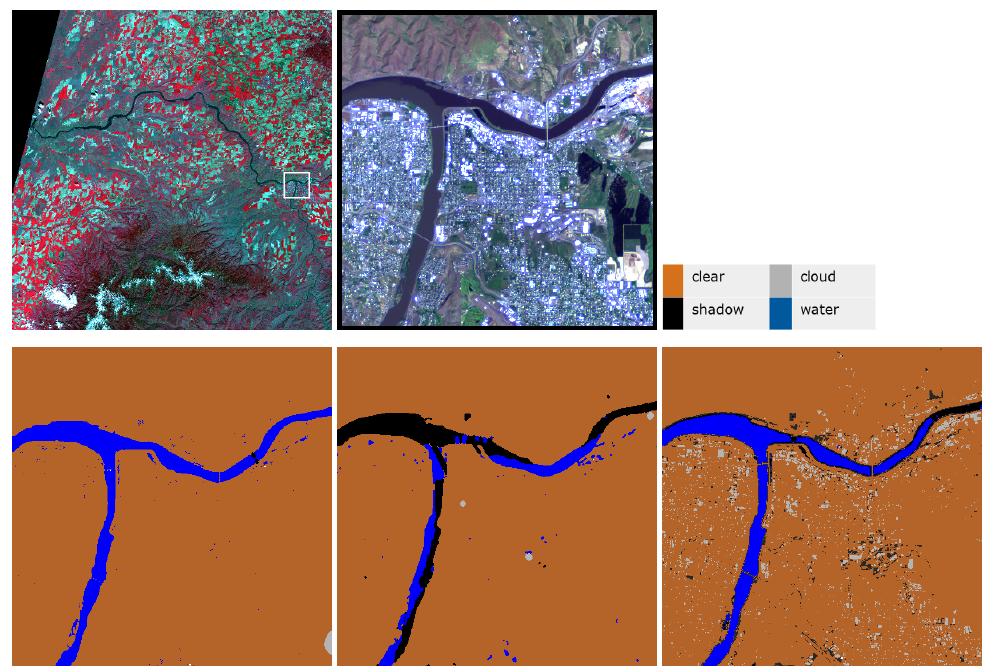
Figure 10. Top row (left to right): CIR (RGB = 865,665,560 nm) composite and true color (RGB = 665,560,443 nm) subset of scene ID 20 (USA Rimrock). Bottom row (left to right): Fmask, ATCOR, and Sen2Cor classification